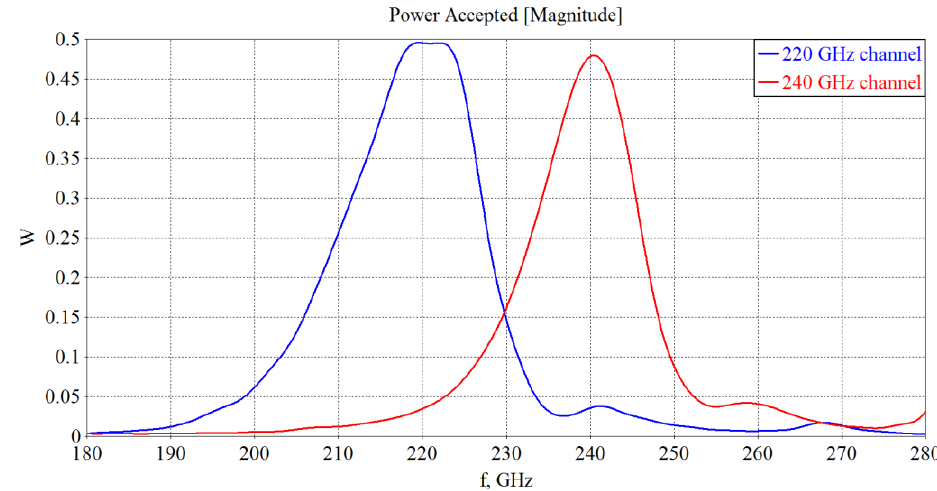
Figure 7. Frequency response curves of the receiving system for LSPE ancillary channels 220 GHz (blue curve) and 240 GHz (red curve). (blue curve) and 240 GHz (red